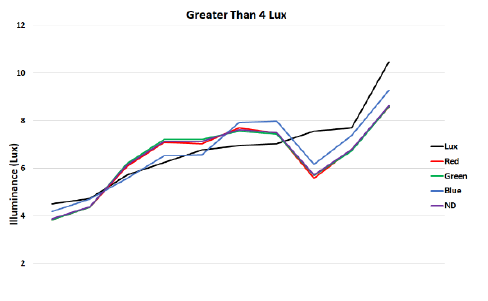
Figure 10. Line graph of illuminance values of all regression model for between 1 to 4 lux.